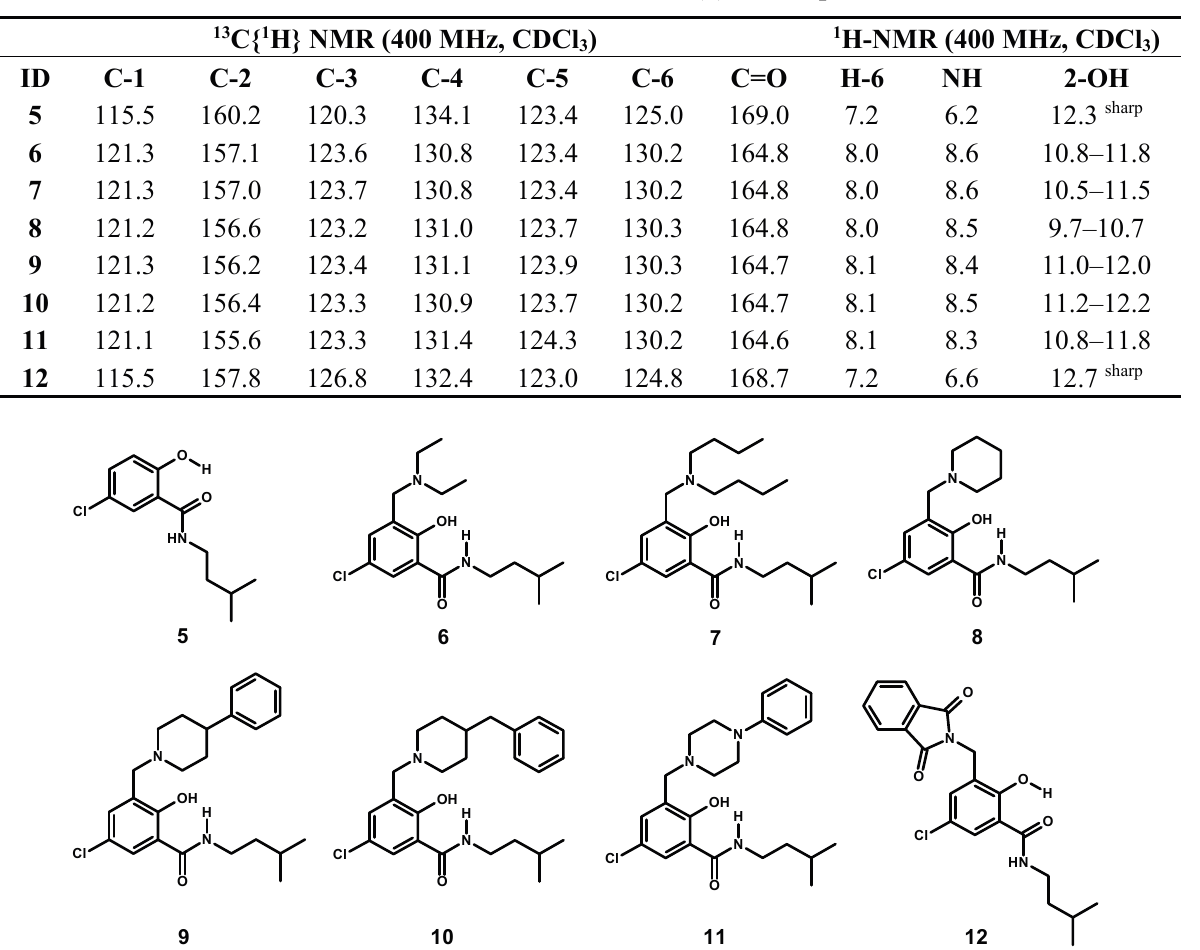
Table 3. Selected 13 C/ 1 H chemical shifts ( δ ) of compounds 5 – 12 .